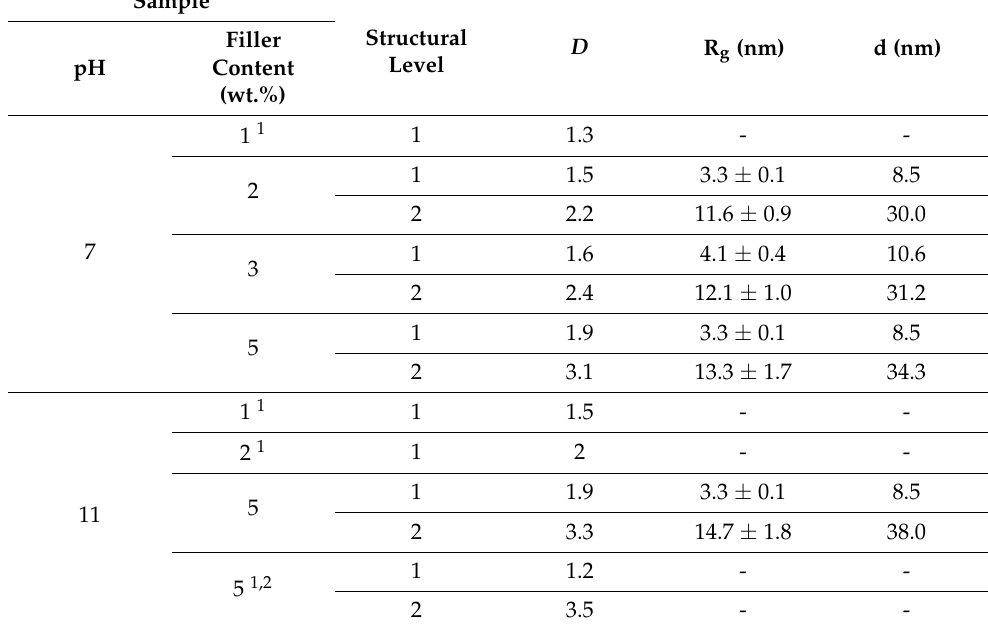
Table 2. Structural parameters (radius of gyration R g ) obtained from fitting the SAXS data to the unified exponential/power-law model with two structural levels. The inorganic domain size d was calculated using Equation (4). The fractal dimension D was measured from the linear slopes of the plots in Figure 4. Sample Structural Filler D R g (nm) d (nm) Level pH Content